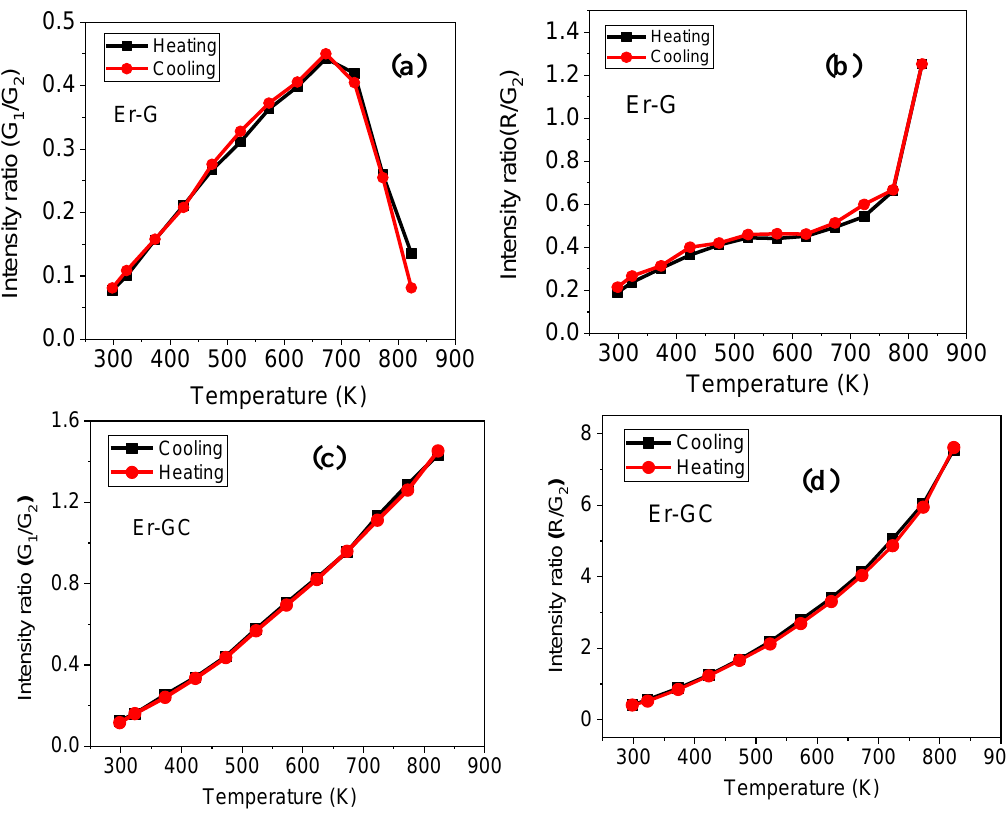
Figure 10. Intensity ratio of transitions ( a , c ) G 1 /G 2 and ( b , d ) R/G 2 in Er-G and Er-GC samples. The FIR of transitions attributed to TCLs (Figure 10a,b) and NTCLs (Figure 10b,d) against temperature (for Er-G sample taken into account up to 673 K) was fitted by ex- ponential equation, Equation (1), and polynomial equation, Equation (4), respectively, shown in Figure 11 for Er-GC sample and in Figure S1 in Supplementary Material for the Er-G